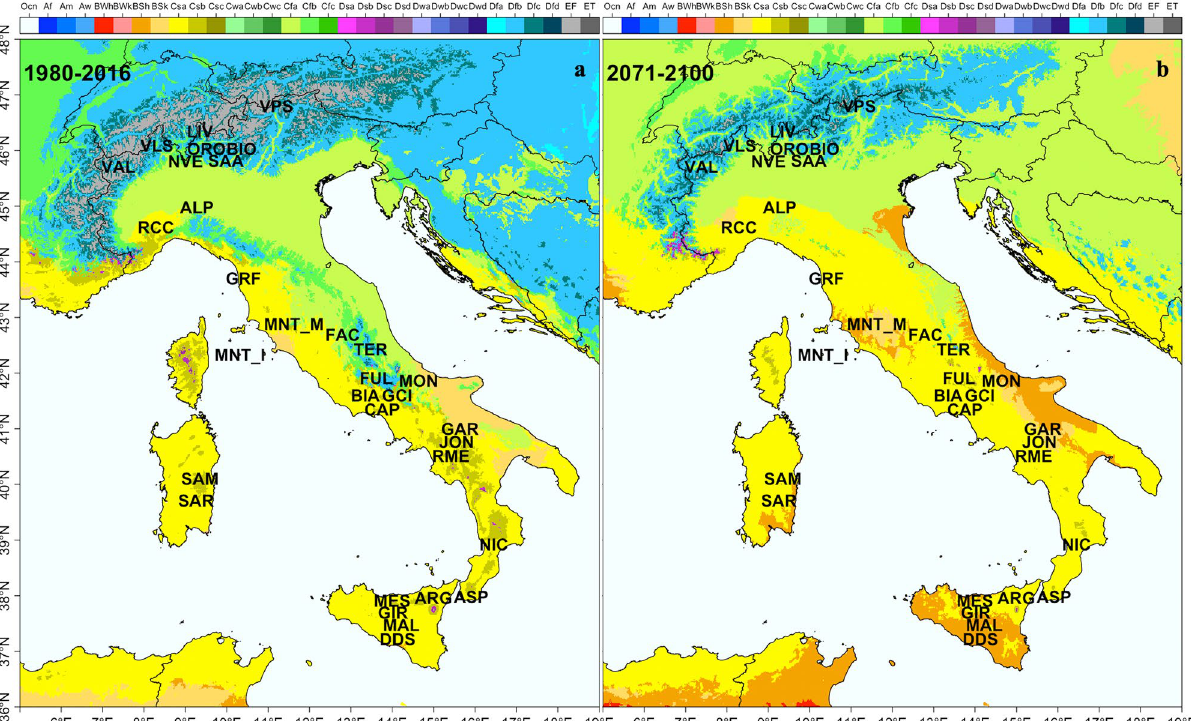
Figure 4. Koppen-Geiger climate maps with classification for Italy ( a ) present day ( b ) future (extended name reported in Table 1). The Maps were generated using R combining the information available in Rubel et al. 42 and Beck et al. 14